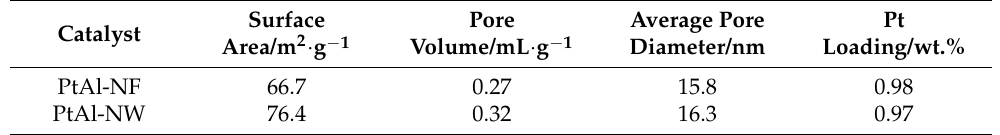
Table 1. The concentration of Pt Present on γ -Al 2 O 3 and BET Surface Area.